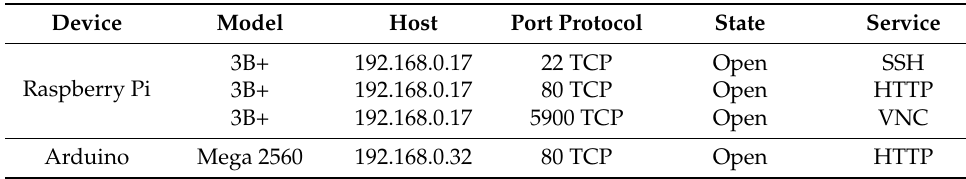
Table 14. Vulnerability on test scenario using Raspberry